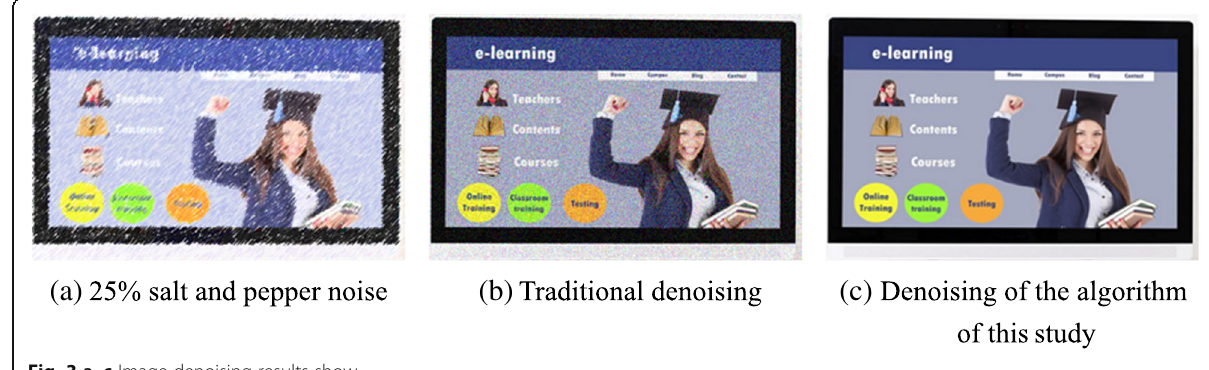
Fig. 3 a – c Image denoising results